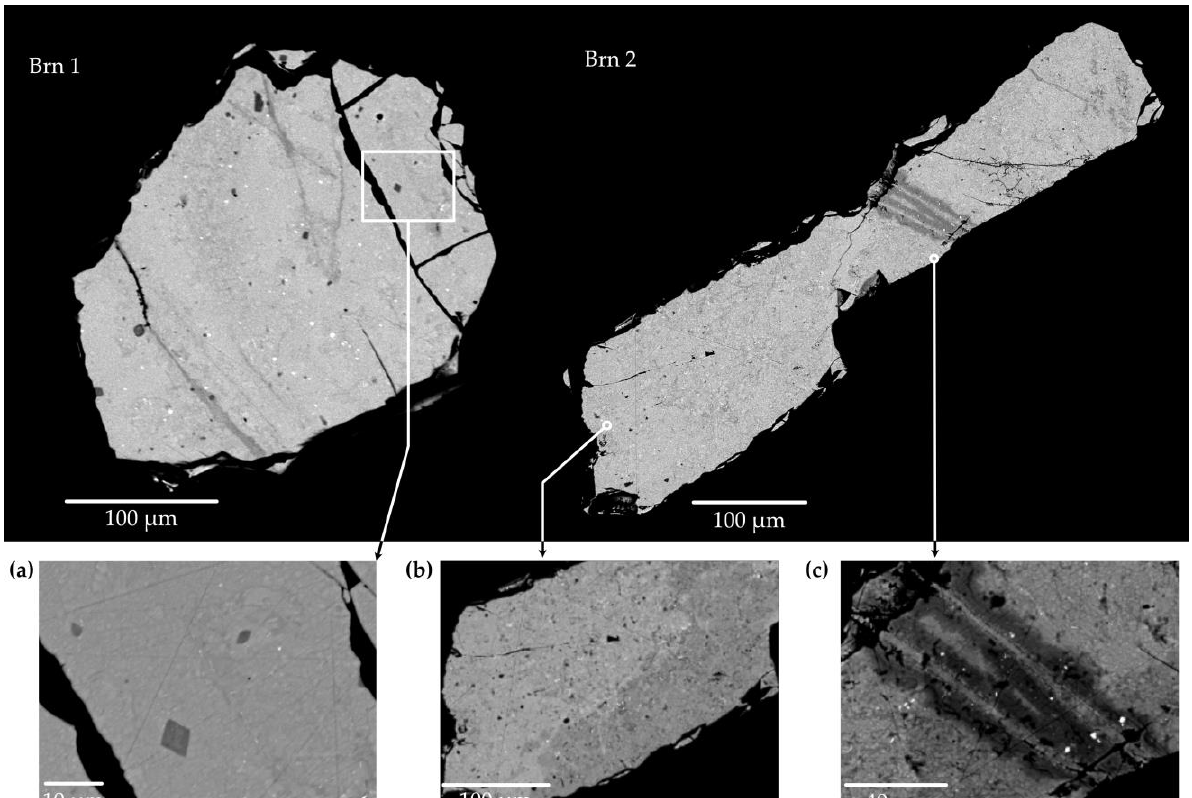
Figure 2. Two pristine grains of brannerite contain some impurities; enlarged areas of grains are shown in ( a – c ). The rhombic crystal of pyrochlore can be seen in ( c ). The altered region is well- represented in grain “ Brn2 ”.